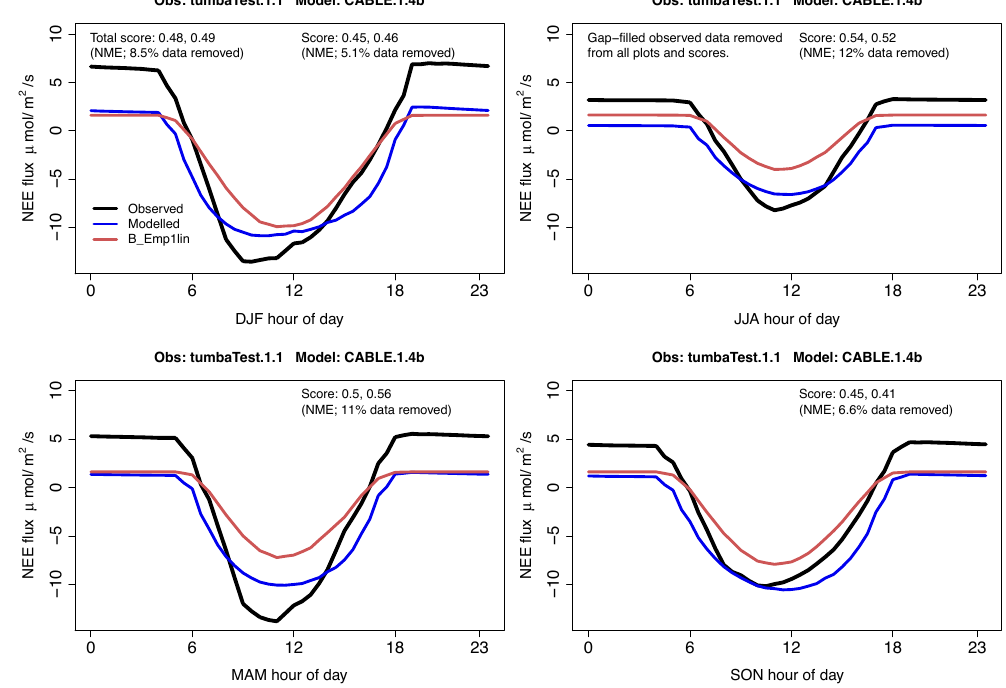
Fig. 2. Average diurnal cycle of net ecosystem exchange of CO 2 (NEE) at a single flux tower site, shown in a separate panel for each season. As in Fig. 1, an out-of-sample linear regression of NEE against downward shortwave radiation (shown in red) performs comparably to a LSM in this instance (blue). Normalized mean error of the average diurnal cycle is used as the scalar metric, shown separately for each panel and combined in the DJF panel. Table 2. A hierarchy of a priori levels of benchmark performance for LSMs, with tiers defined by increasingly complex empirical models provided with more meteorological and site description